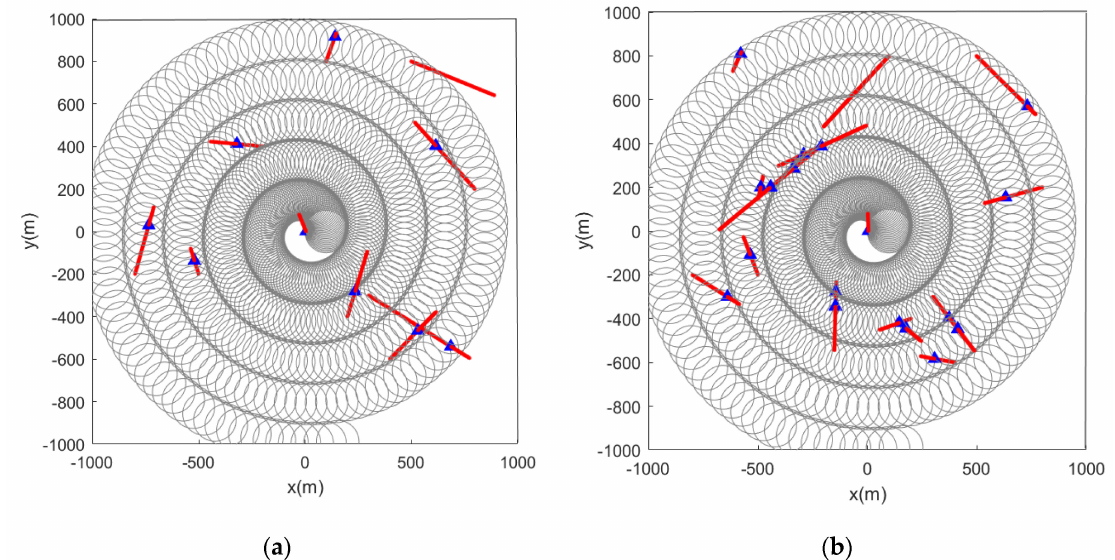
Figure 13. Estimated position of dynamic feature points using the GLMB algorithm (the red track is the feature point motion track; the blue marks indicate the estimated positions of the feature points in the scene). ( a ) Sensor detection radius is 100 m and there are 10 feature points in the scene; ( b ) sensor detection radius is 100 m and there are 15 feature points in the